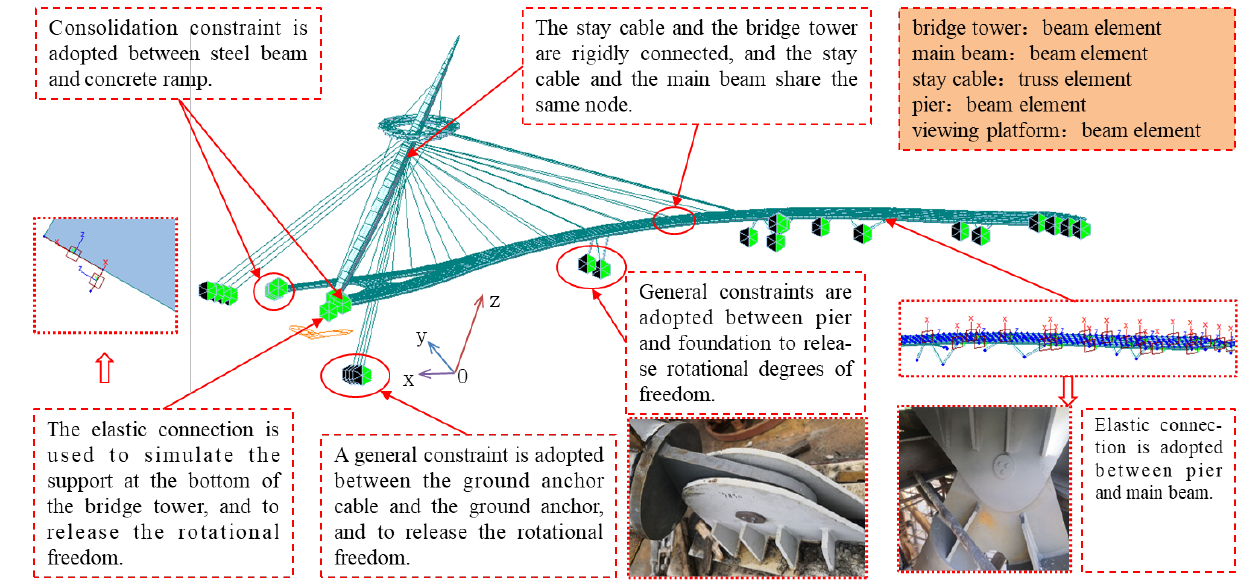
Figure 17. Integral finite element model of the cable-stayed bridge.